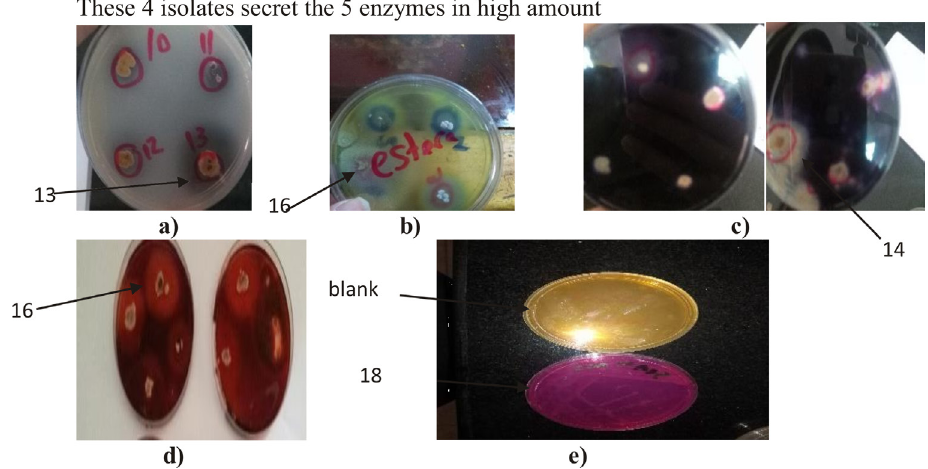
Fig. 2. Qualitative screening of different enzymes in different isolates ( a : skimmed milk agar indicates a clear zone around the colony for caseinase producing microorganisms, b : Tween substrate plates showed insoluble crystals around the colony and opaque colony indicate esterase positive strains, c : starch plate indicate clear zone against dark blue on the plate for positive amylase strains, d : CMC Agar plates show clear zones against dark brown around the colonies indicating cellulose hydrolysis, e : Czapek Dox show pink coloration for cultures indicate positive production of L- asparaginase with blank (yellow in color). Arrows and numbers show the isolates with largest enzyme activity and their